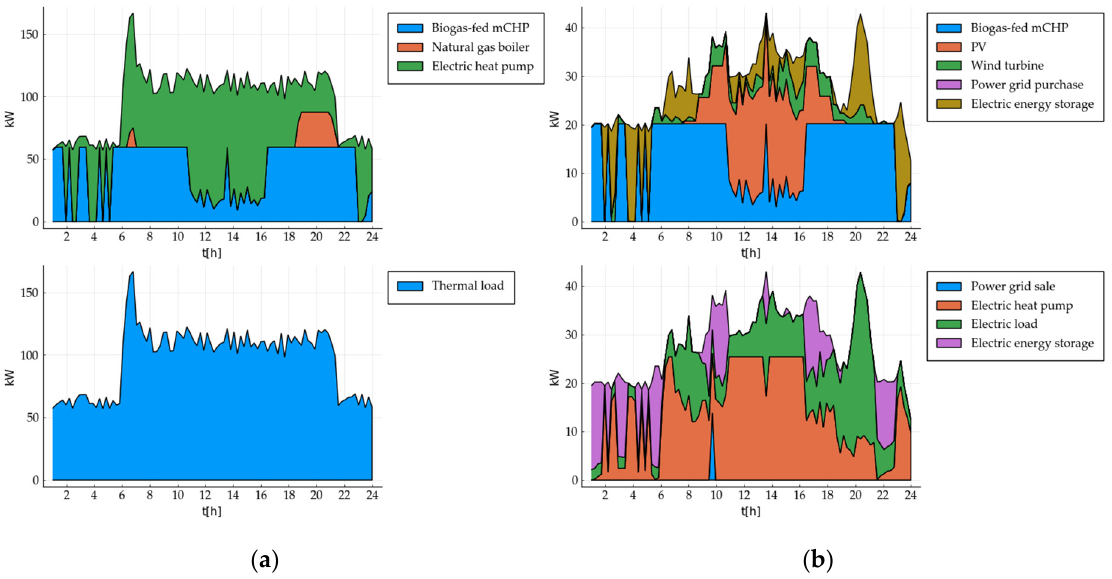
Figure 11. Daily consumption and production pattern in case of investment cost inclusion for Case 2: thermal production ( a -up) consumption ( a -down); electricity production ( b -up) consumption ( b -down).